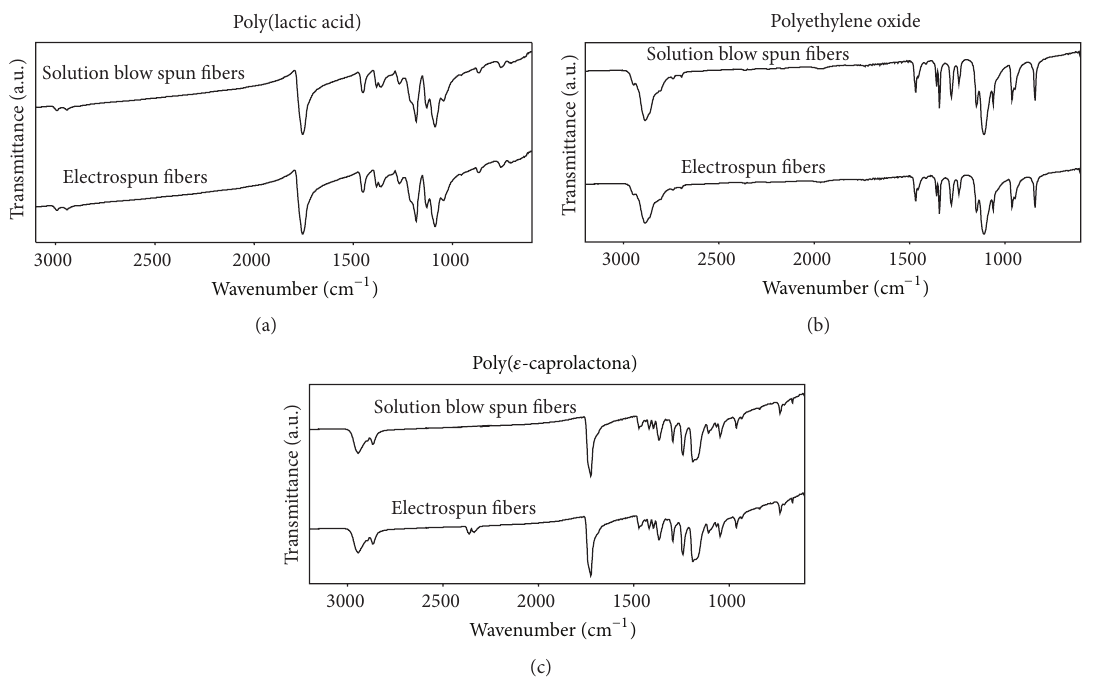
Figure 5: FTIR spectra for (a) PLA, (b) PEO, and (c)